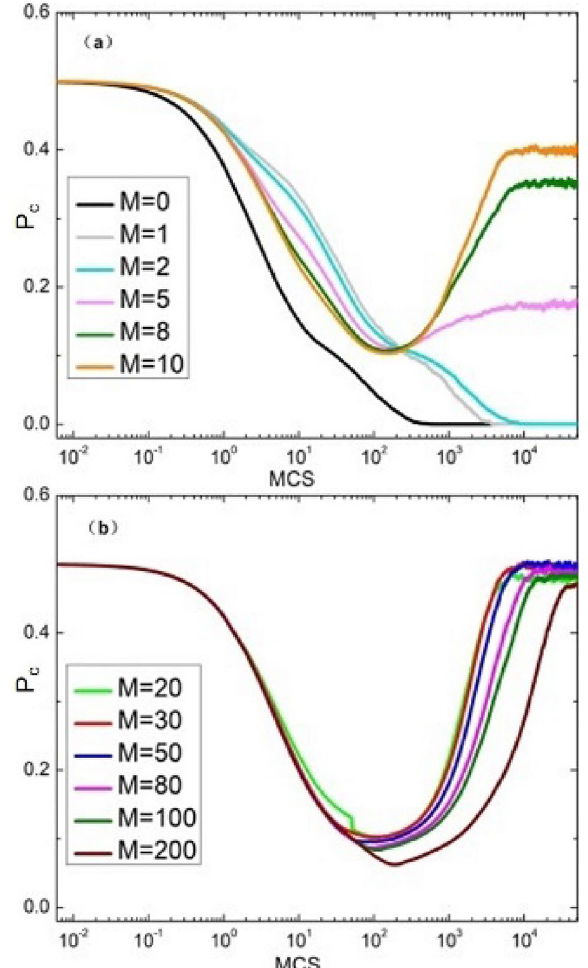
Figure 3. When β =0.5, K = 0.1 , the evolution curve of cooperation rate with time under different M